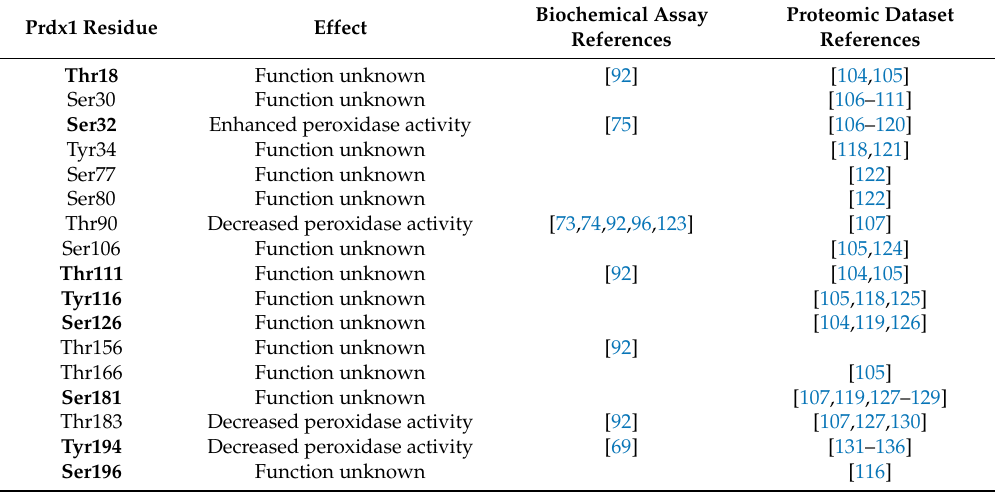
Table 1. Phosphorylation of Prdx1 can increase or decrease peroxidase activity to coordinate cell signaling. Phosphorylation sites that correspond to human Prdx1 in biochemical assays and proteomic studies are referenced are indicated. Phosphorylation sites that have been identified in proteomic screens in cancer models are in bold.